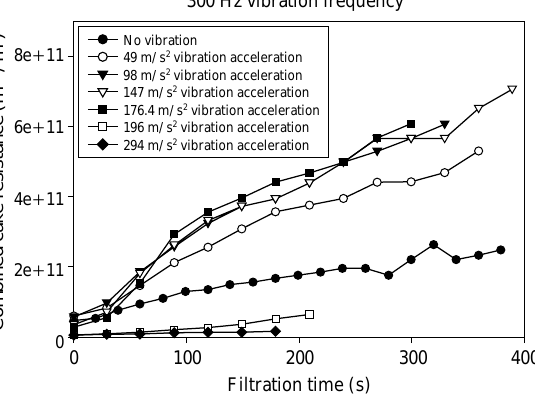
Fig. 10 Variation of the combined cake resistance with time dur- ing the vibration-assisted filtration process with the medi- um vibrating at 300 Hz.